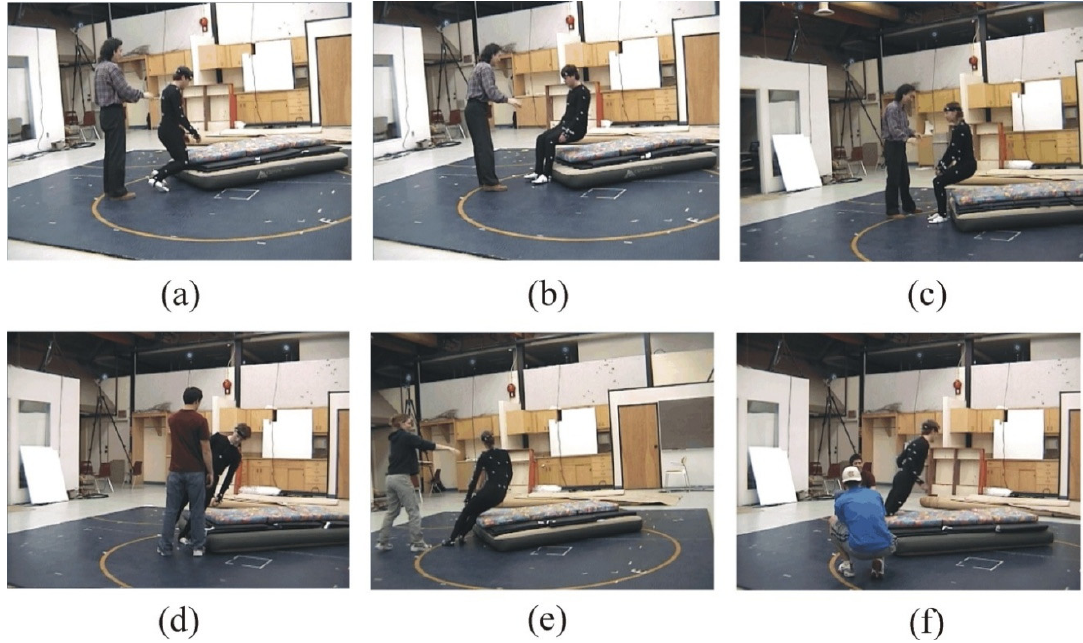
Figure 2. Motion analysis/quantification of the common type of falls among seniors: ( a ) a forward fall; ( b ) a backward fall; ( c ) a sit fall (downward); ( d ) a left fall; ( e ) a right fall; ( f ) a trip fall.